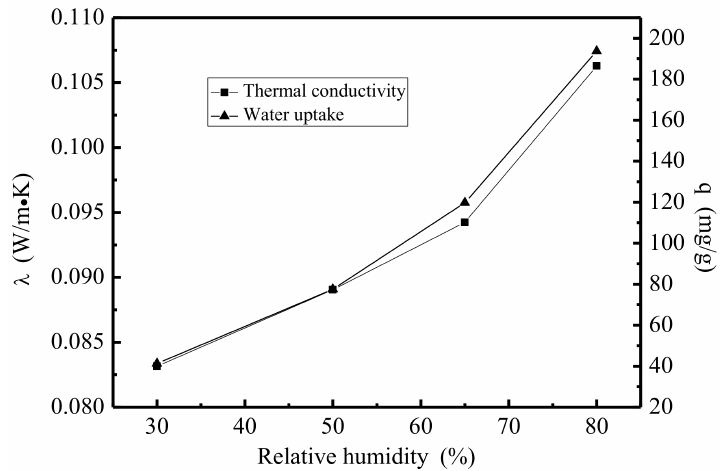
Figure 8. Effective thermal conductivity and water uptake of the solid amine at different